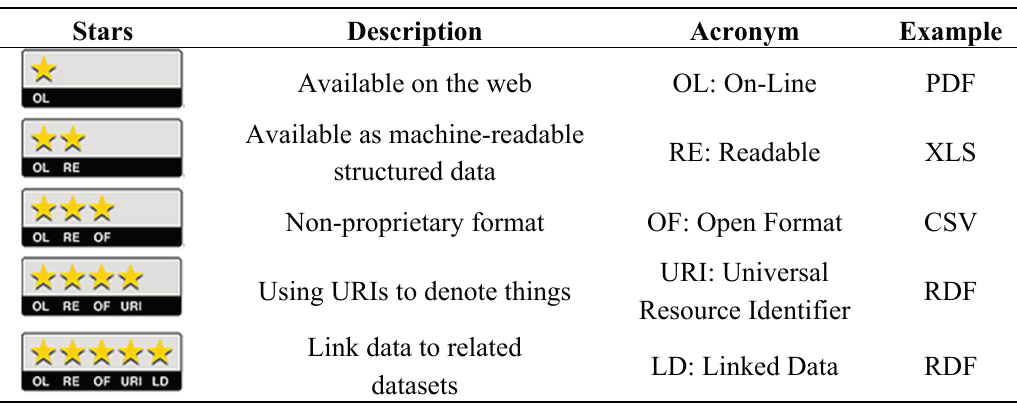
Table 2. 5-star Linked Data rating